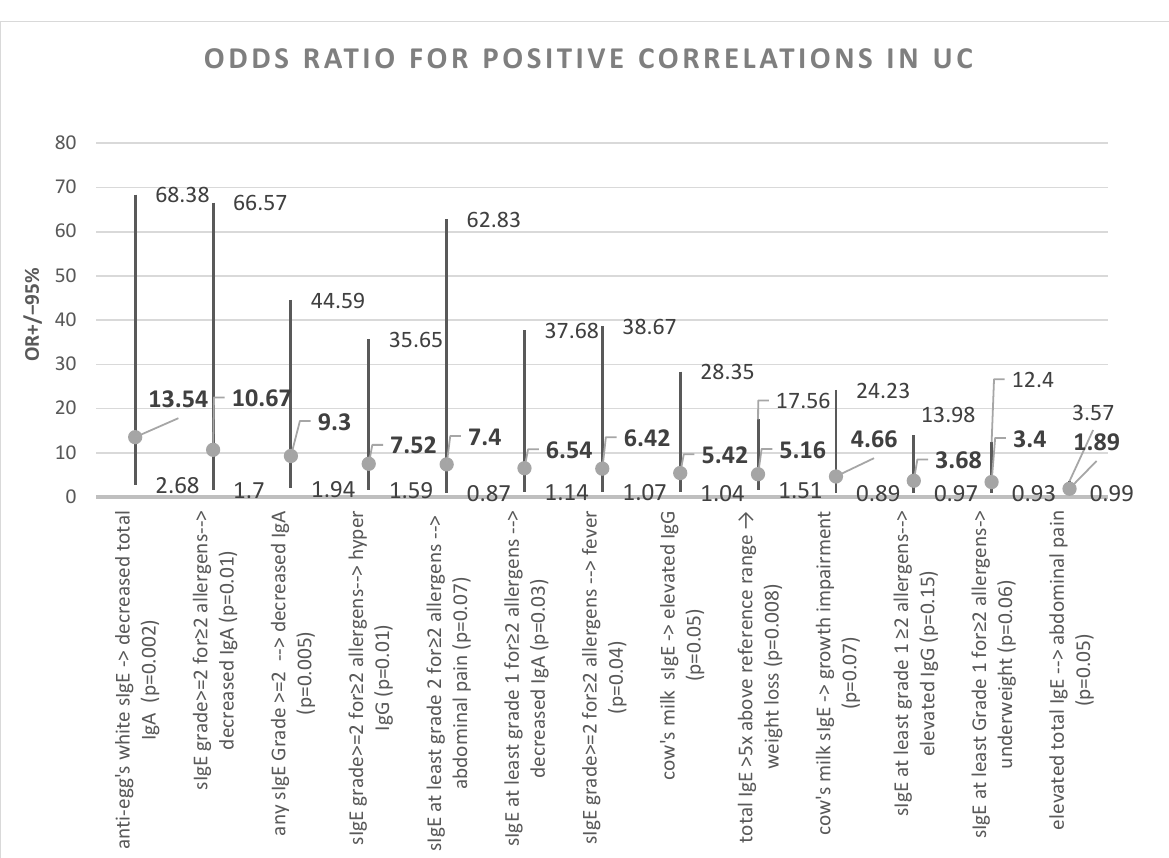
Figure 6. UC—odds ratios for positive correlations.